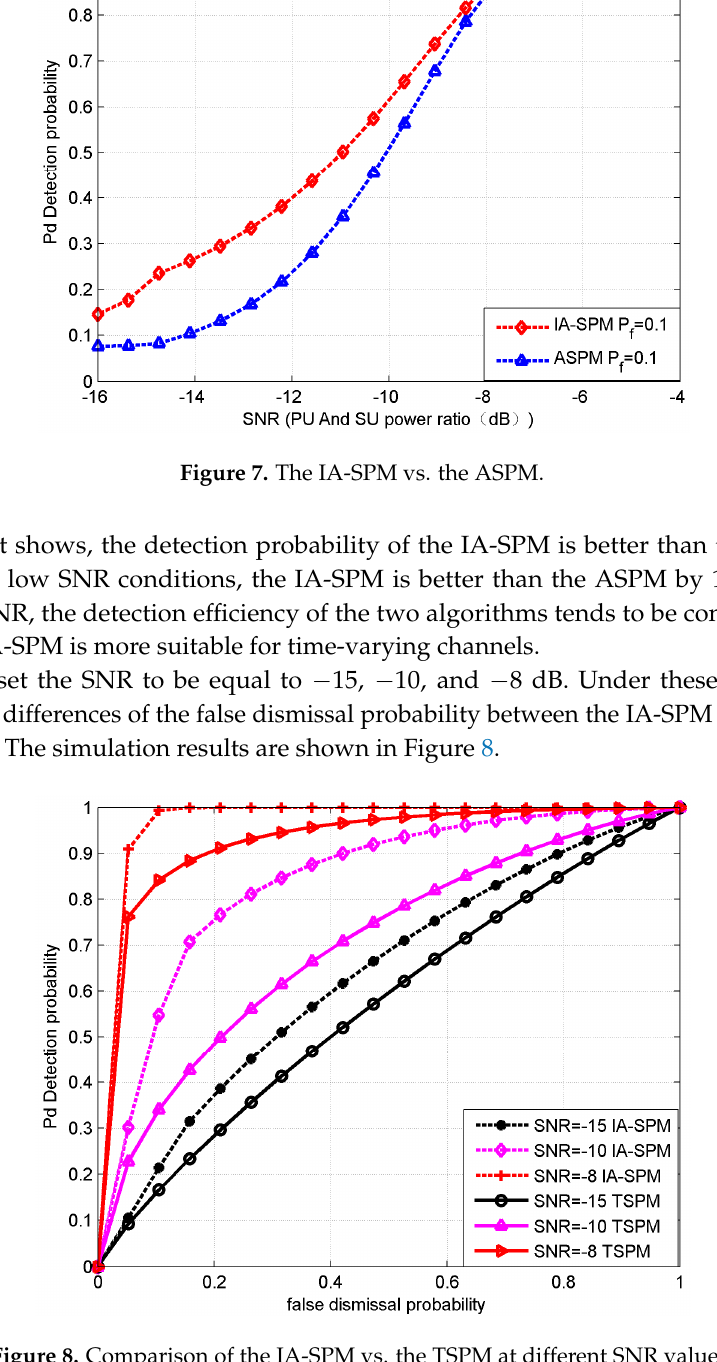
Figure 6. Comparison of the IA-SPM vs. the TSPM with different false dismissal probabilities.